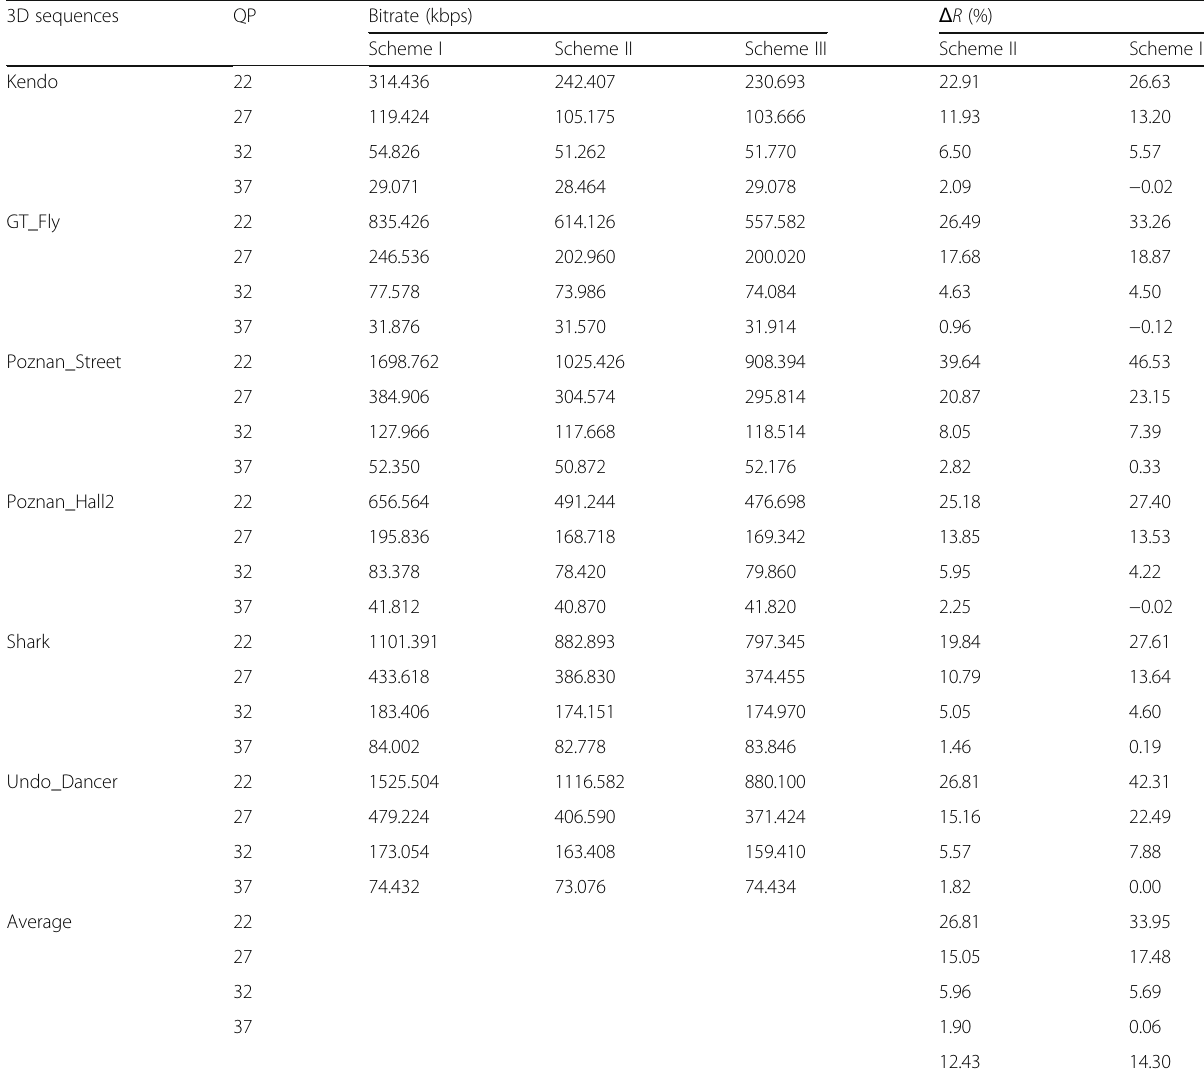
Table 12 The comparison of the bitrate saving performance of the three coding schemes 3D